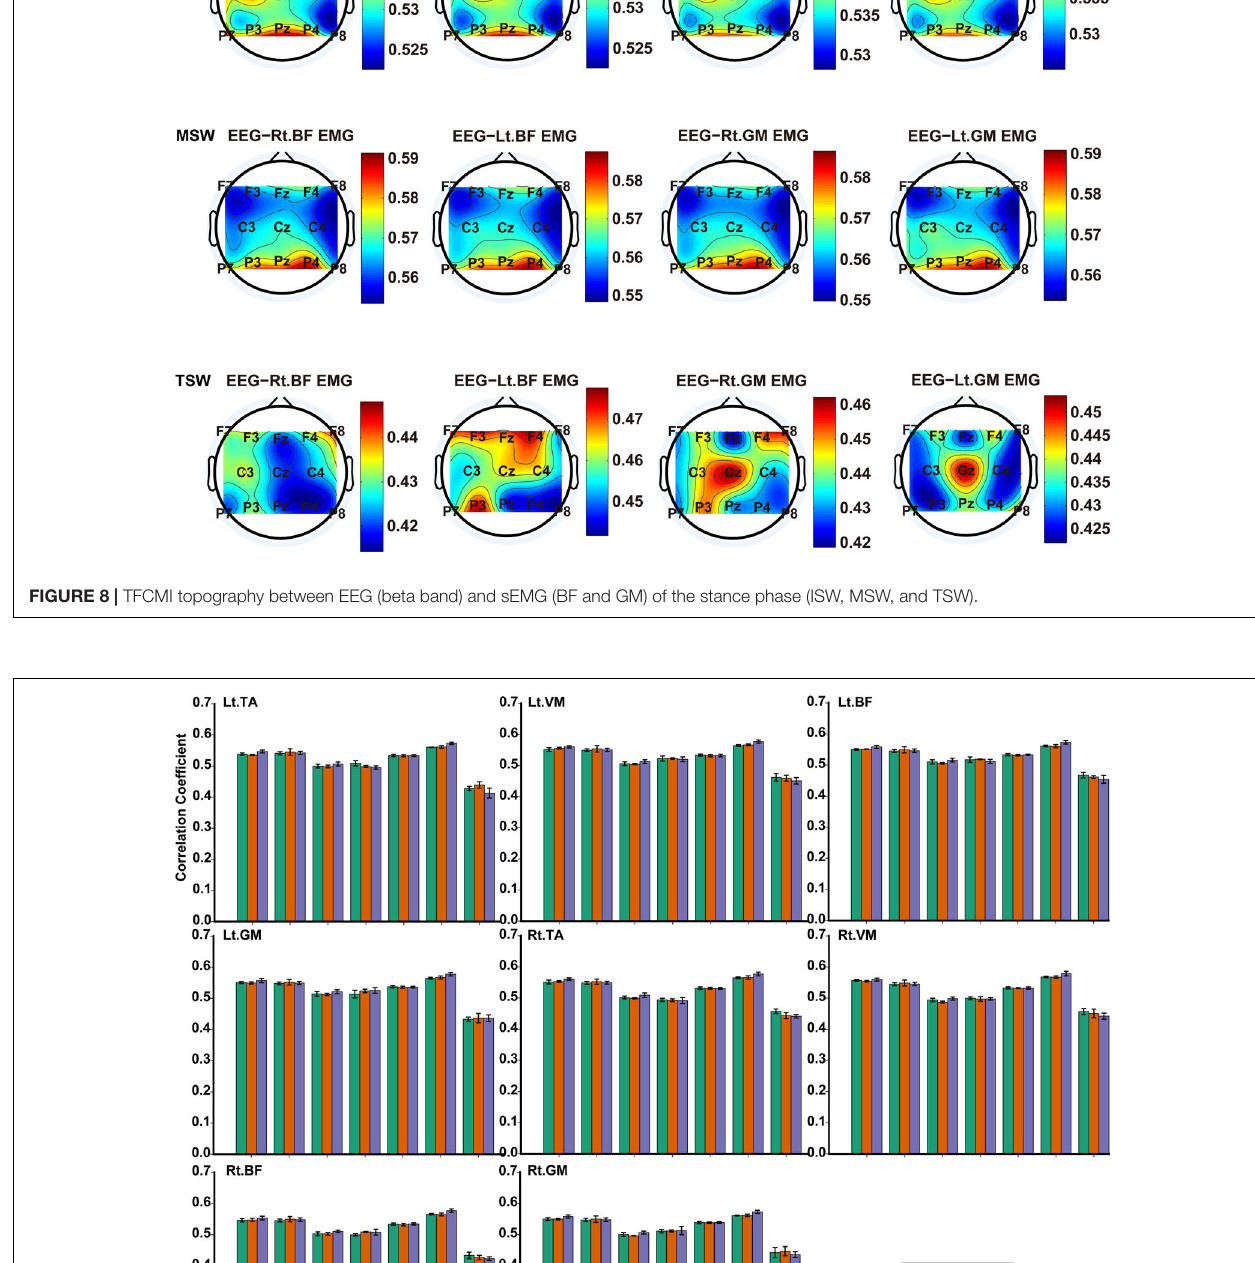
Frontiers in Neuroscience |